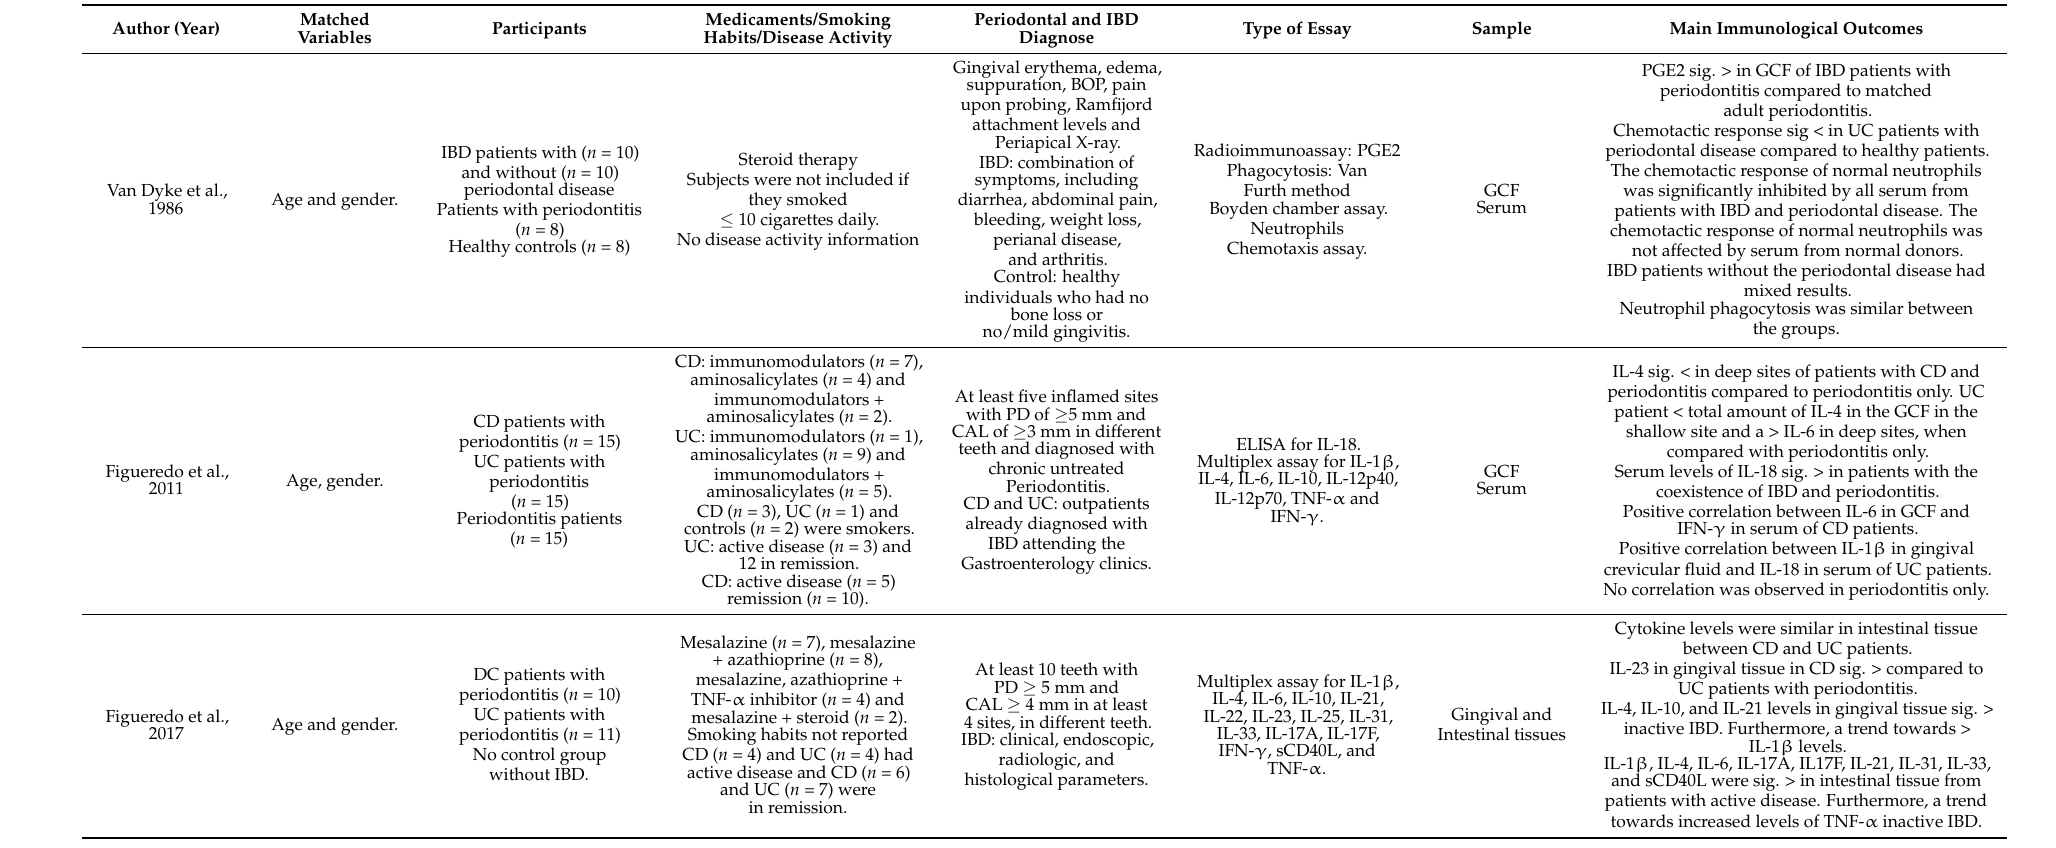
Table 1. Characteristics of the included